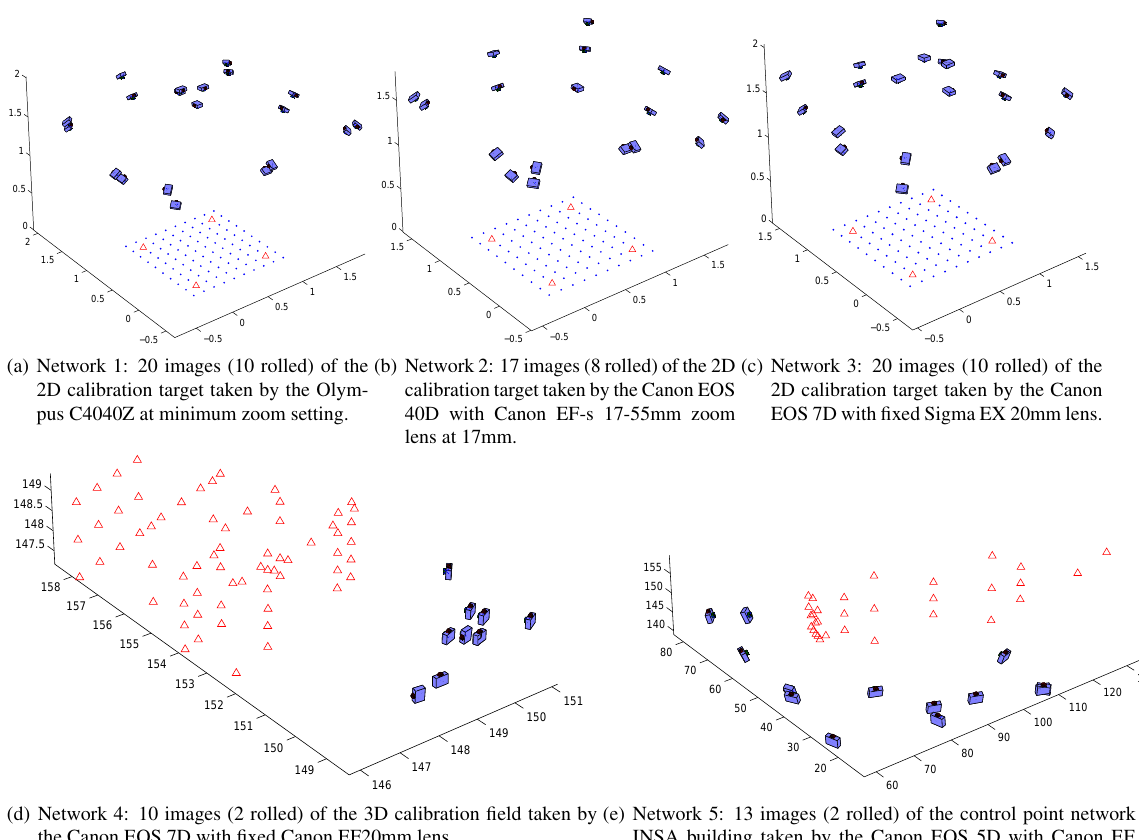
(d) Network 4: 10 images (2 rolled) of the 3D calibration field taken by the Canon EOS 7D with fixed Canon EF20mm lens. Figure 2: The camera networks used for the calibrations. Control points are plotted as red triangles, object points as blue dots. The object space unit is meters.